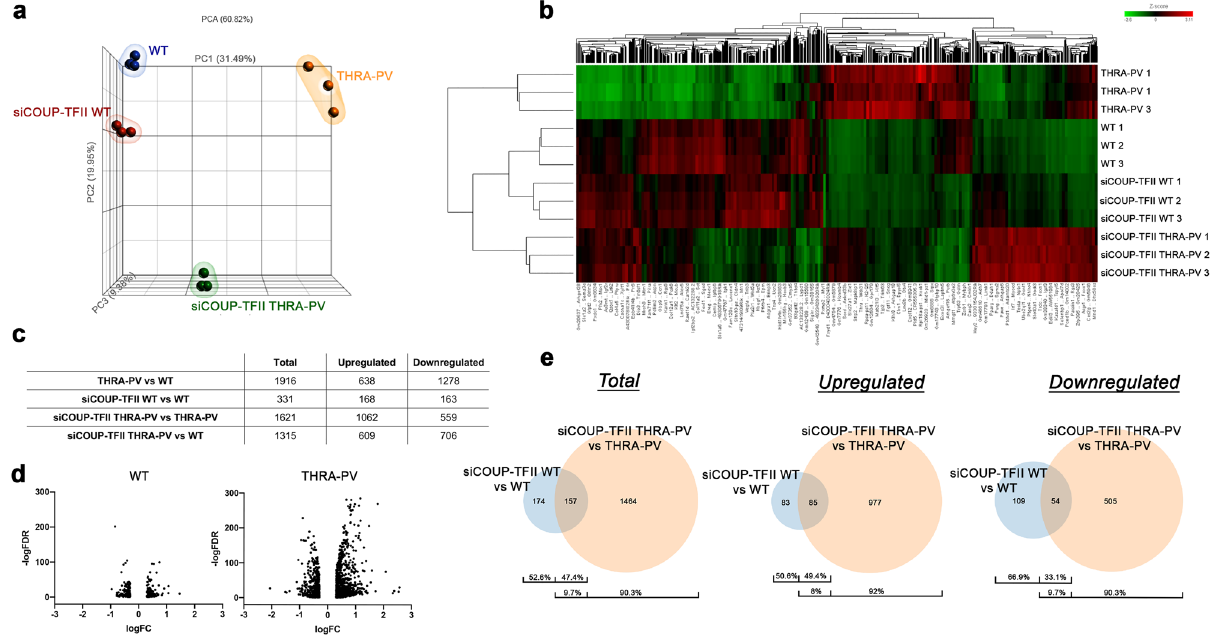
Figure 4. RNA-sequencing profiling of THRA-PV and WT myoblast after COUP-TFII silencing. ( a ) 3D Principal Component Analysis plot (PCA) for WT and THRA-PV myoblasts before (WT and THRA-PV) and after (siCOUP-TFII WT and siCOUP-TFII THRA-PV) COUP-TFII silencing. ( b ) Heatmap and hierarchical clustering analysis of the 3072 differentially expressed genes among WT, WT siCOUP-TFII, THRA-PV, and THRA-PV siCOUP-TFII. Downregulated genes are represented in green, upregulated genes are represented in red. ( c ) Number of total, upregulated and downregulated differentially expressed genes in THRA-PV myoblasts (THRA-PV vs WT) and after COUP-TFII silencing in WT (siCOUP-WT vs WT) or THRA-PV (siCOUP-TFII THRA-PV vs THRA-PV) myoblasts and siCOUP-TFII THRA-PV vs WT ( d ) Volcano plot representation of differential expression analysis of genes after COUP-TFII silencing in WT and THRA-PV myoblasts. The x-axis shows log 10 fold-changes in expression and the y-axis the log 10 odds of FDR. ( e ) Venn diagrams representing summary of the total differentially expressed, upregulated and downregulated genes after COUP-TFII silencing in WT and THRA-PV